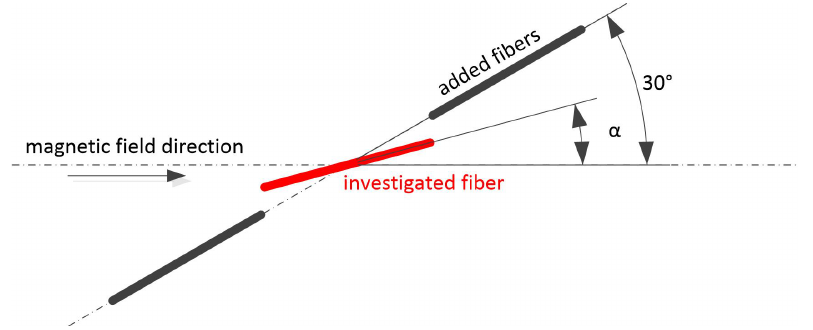
Figure 12. The arrangement of fibres used to investigate fibre